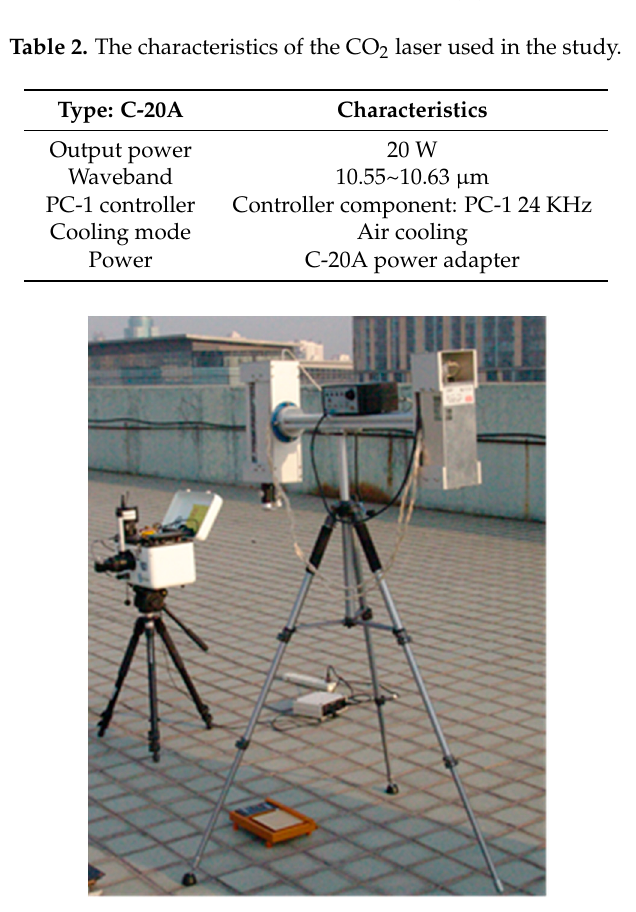
Figure 2. Air-cooling 10.6 µm CO 2 laser source and the 102F FTIR spectrometer.